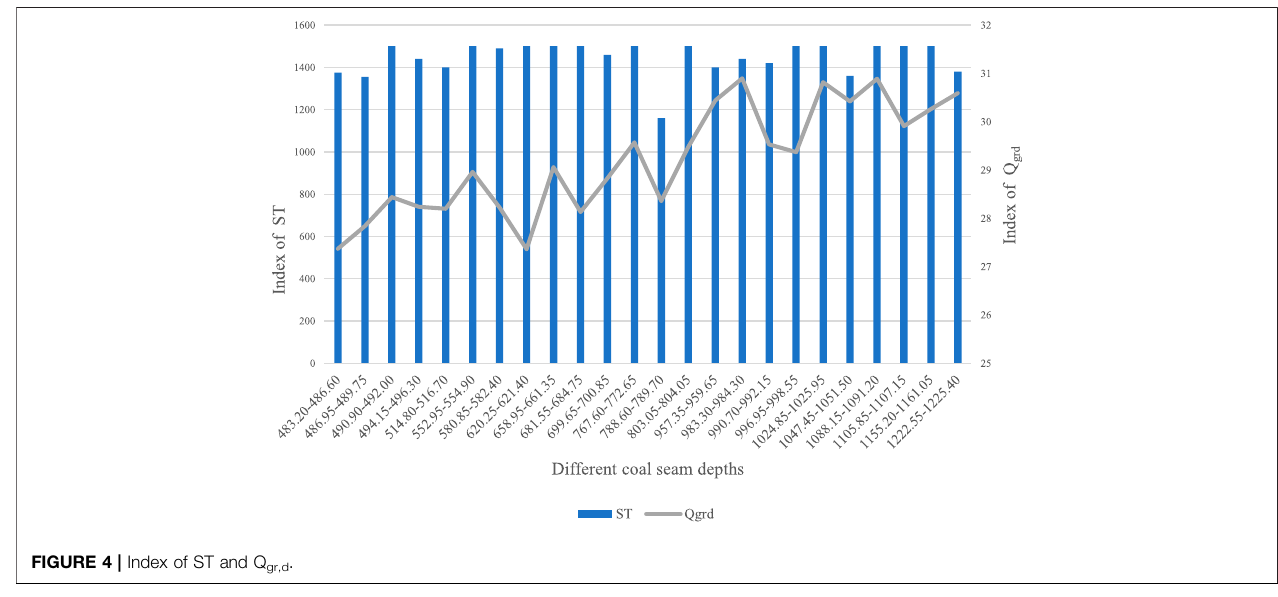
FIGURE 4 | Index of ST and Q gr,d .